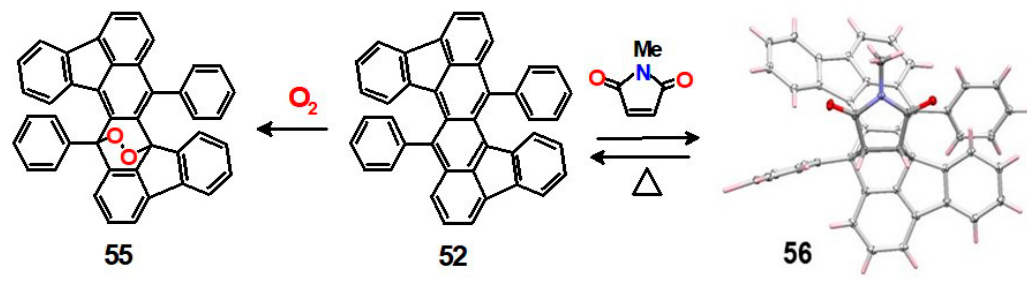
Figure 17. Reactions of tetracene 52 with oxygen to form 55 , and N-methylmaleimide to form 56 .